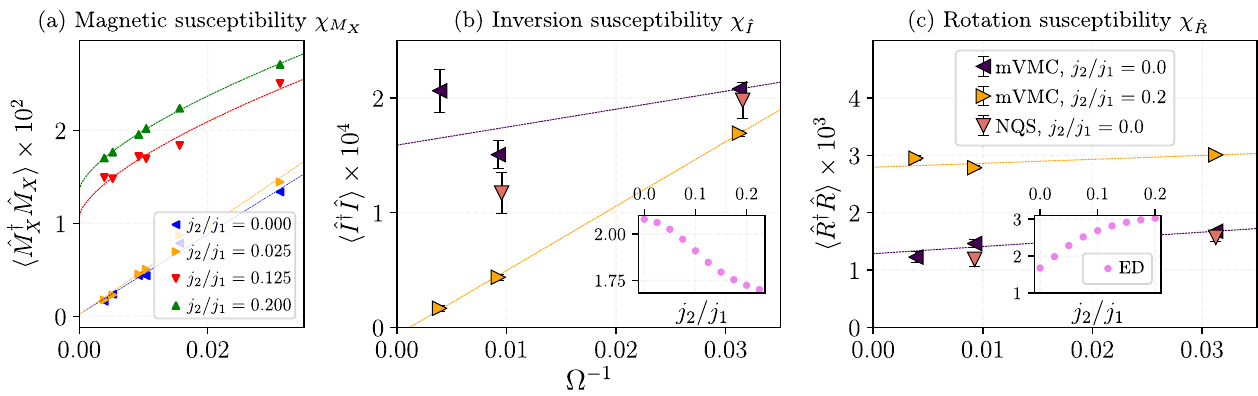
FIG. 5. Susceptibilities towards SU ð 2 Þ , rotation, and inversion symmetry breaking at the λ ¼ 1 point. (a) Magnetic order susceptibility at the k ¼ X point extrapolated to infinite volume using Ω − 1 scaling in the nonmagnetic phase ( j 2 =j 1 ¼ 0 . 0 , 0.025) and Ω − 2 = 3 in the ordered phase ( j 2 =j 1 ¼ 0 . 125 , 0.2). (b) Inversion-symmetry-breaking susceptibility χ ˆ I as a function of inverse volume obtained within the NQS and mVMC methods. The dashed lines show linear infinite-volume extrapolation at j 2 =j 1 ¼ 0 and j 2 =j 1 ¼ 0 . 2 . The inset shows the susceptibility dependence as a function of j 2 =j 1 obtained on a 4 × 2 3 cluster. (c) Rotation-symmetry-breaking susceptibility χ ˆ R as a function of inverse volume obtained within the NQS and mVMC methods. The dashed lines show linear infinite-volume extrapolations at j 2 =j 1 ¼ 0 and 0.2. The inset shows the susceptibility dependence as a function of j 2 =j 1 obtained on a 4 × 2 3